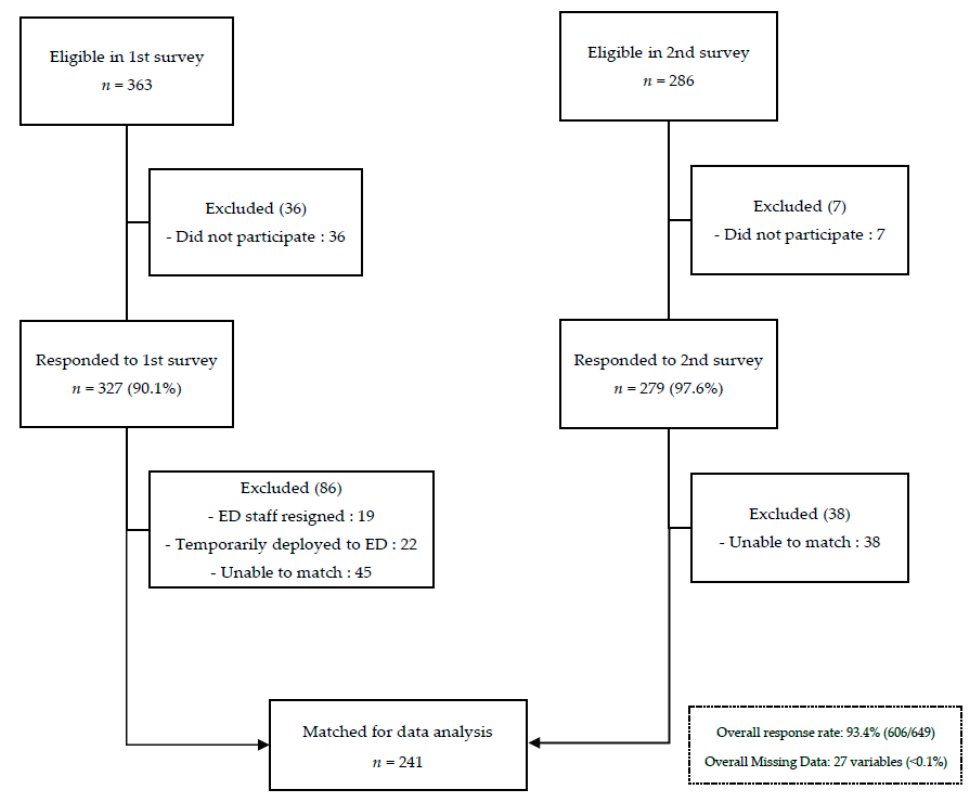
Figure 1. Flow diagram of the COVID-19 longitudinal study carried out in June 2020 (1st survey) and June 2021 (2nd survey).